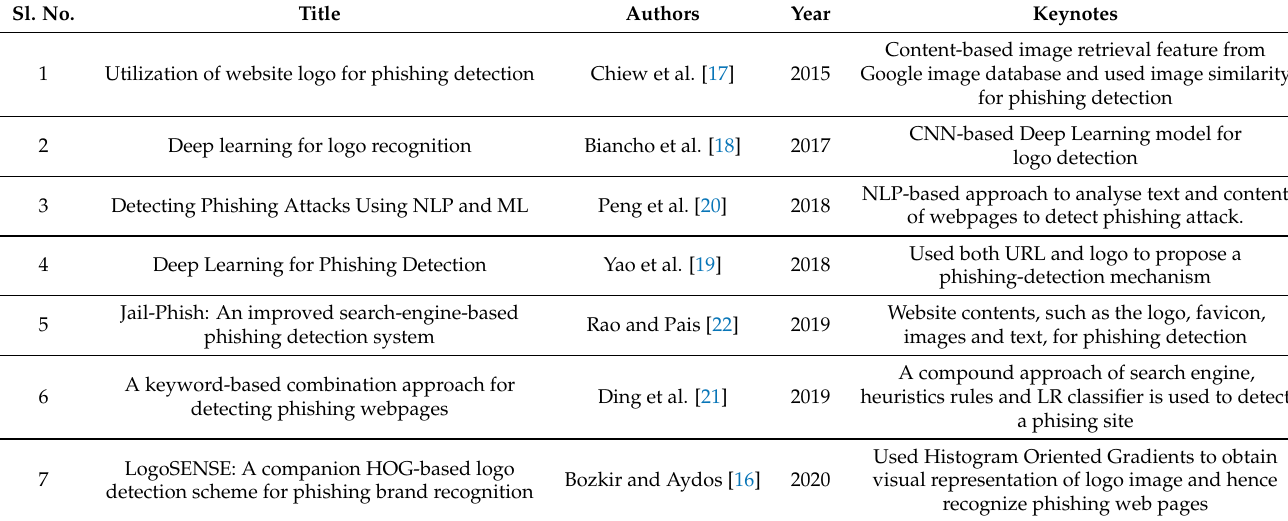
Table 1. Summary of phishing-detection